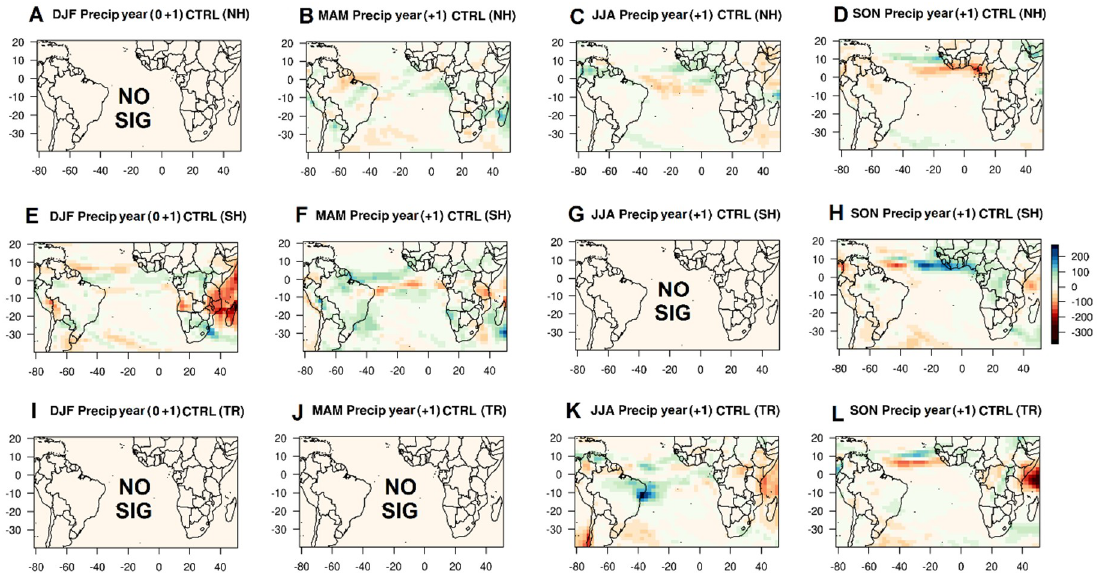
Figure 10. VOLC precipitation composites (mm/3 months) for one year after volcanic eruption as listed in Table 1. Lines correspond to the class of the eruptions (NH – A , B , C, and D ; SH – E , F , G , and H ; and TR – I , J , K , and L ), and columns refer to the seasonal SEA (DJF, MAM, JJA, and SON).